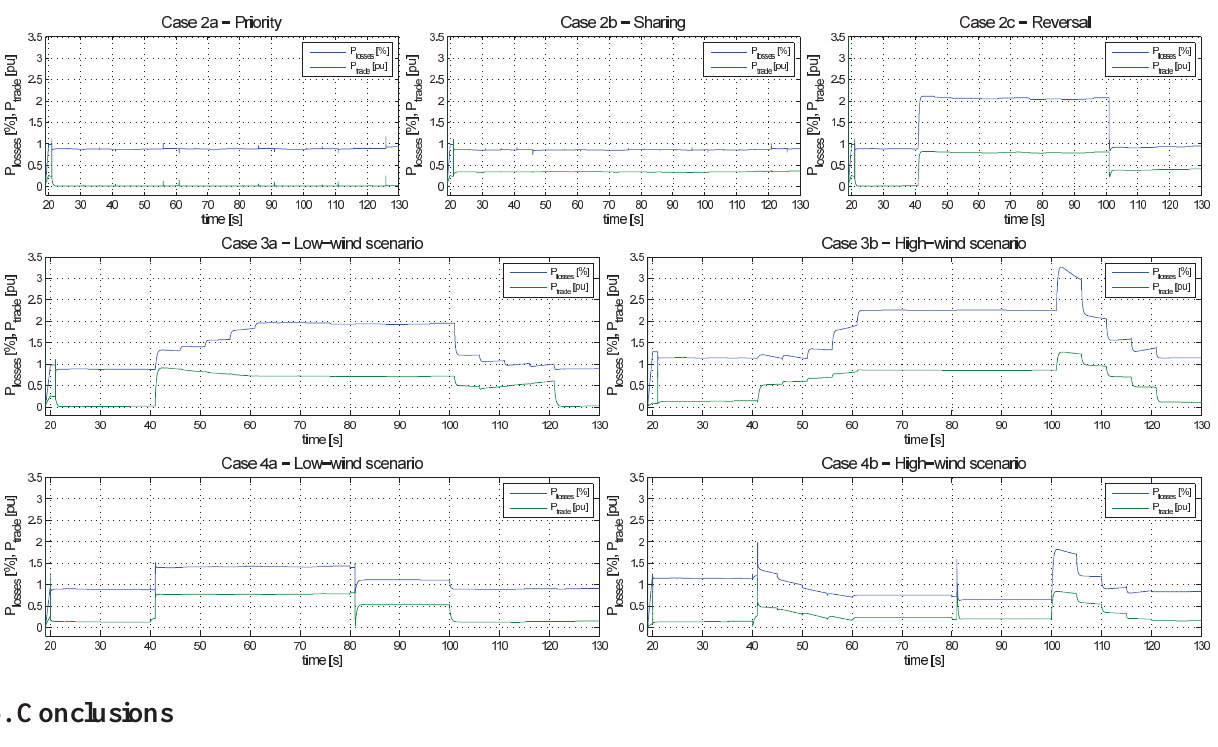
Figure 15. Transmission losses in the MTDC system in percentage of the total generated power and power traded in the MTDC system in per unit of the system power